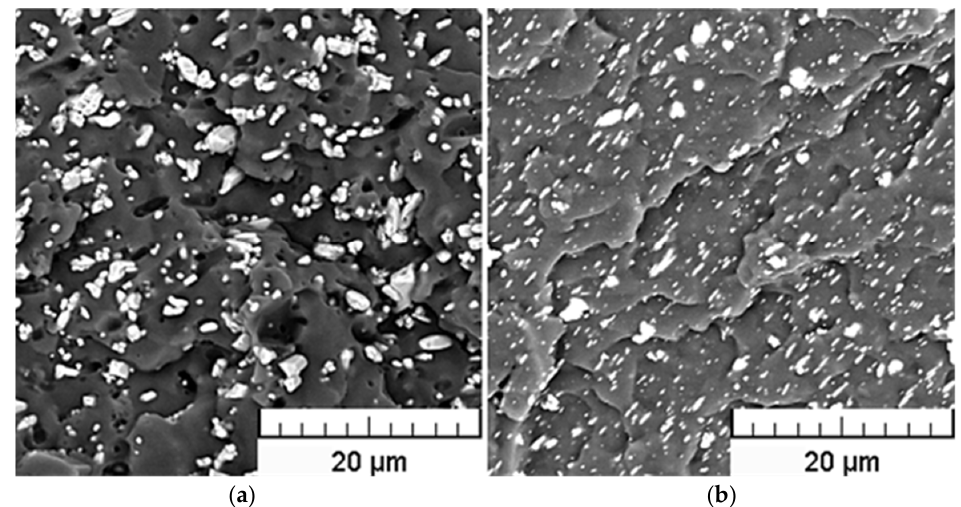
Figure 4. SEM pictures of the cross-sections of 17Ba ( a ) and 10Bi ( b ) samples.